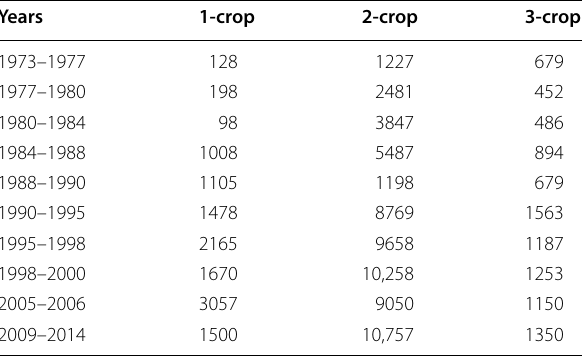
Table 3 Change in cropland in study area from 1973 to 2014. Source: Agriculture office (2015)